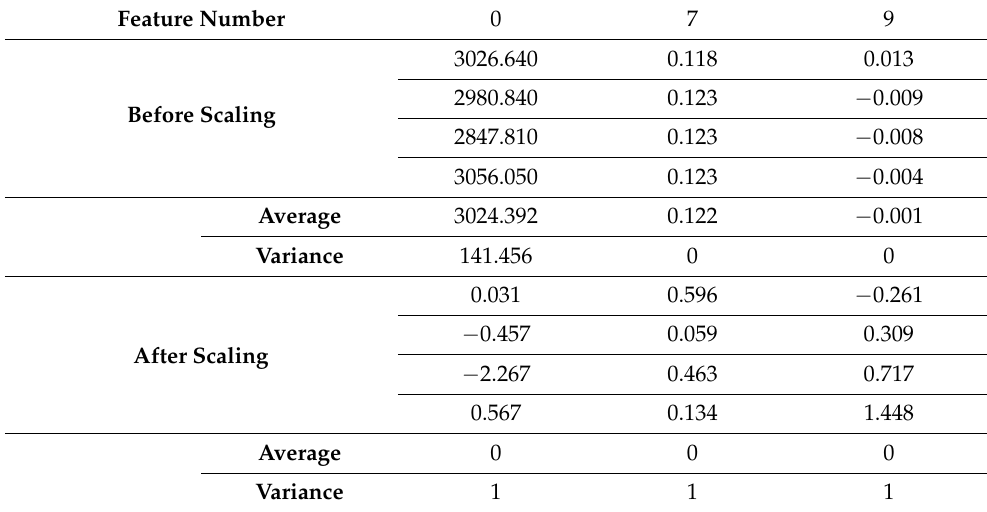
Table 4. Comparison before and after data